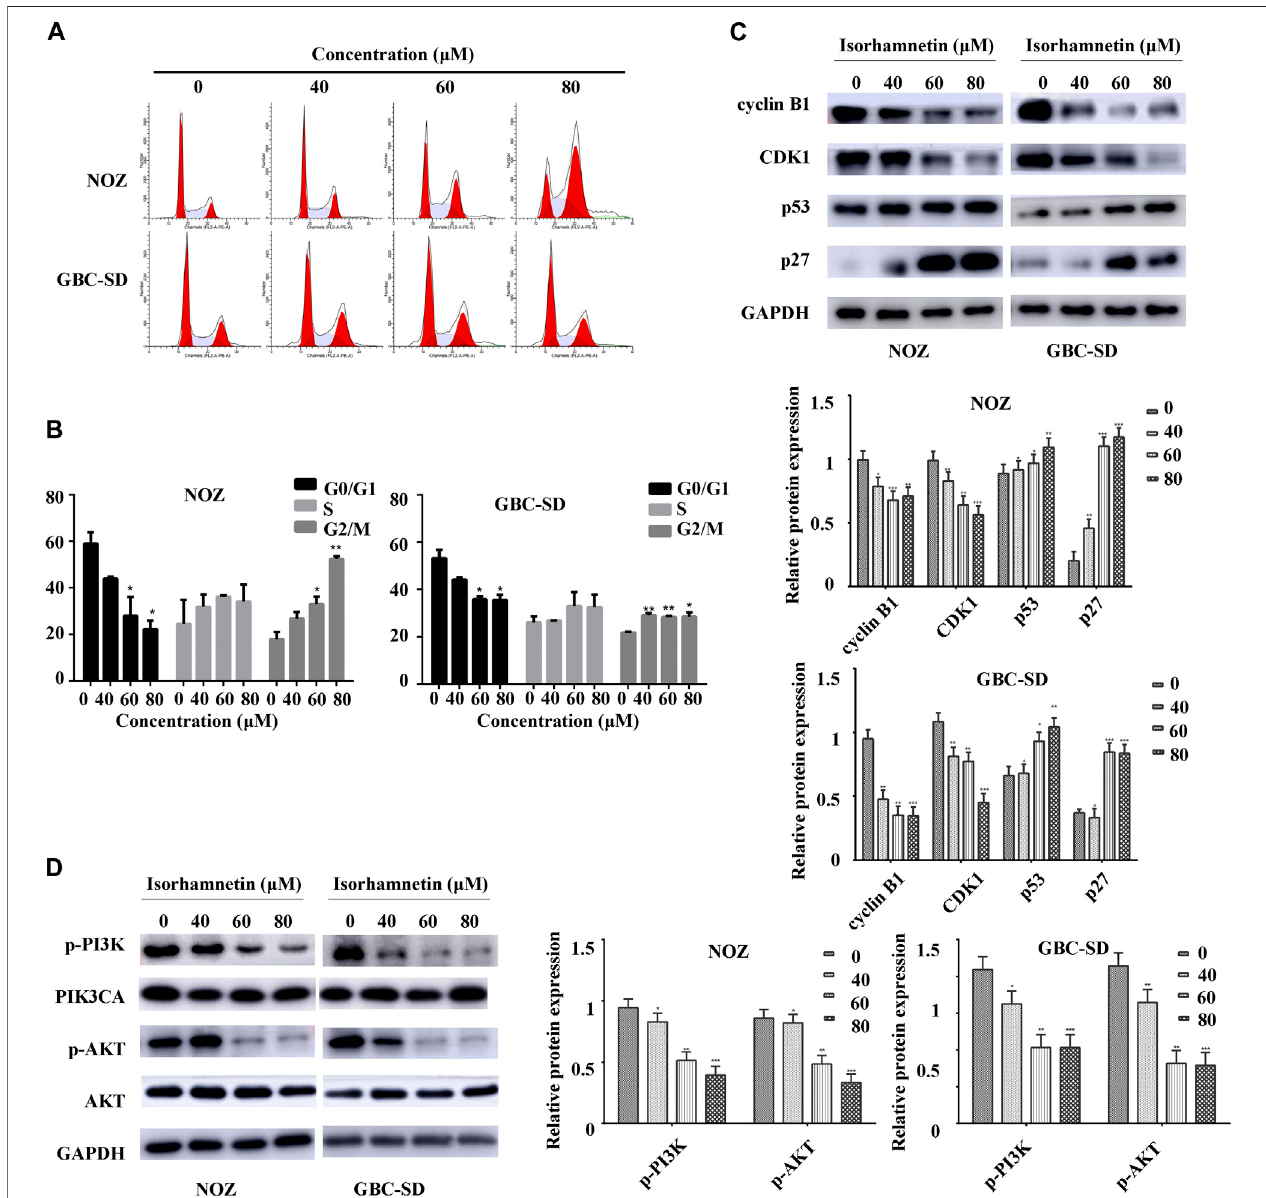
FIGURE4| IsorhamnetintriggerscellcyclearrestintheG2/MphaseandregulatesPI3K/AKTcascade. (A) CellcyclephasesofNOZandGBC-SDcellsexposedto isorhamnetin(0, 40,60,and 80 μ M) for48 hanalyzed using fl owcytometry. (B) Cell cyclephase distributionindicated asthemean ± SD( n (cid:2) 3). (C) Levelsofexpression of cyclin B1, CDK1, p27, and p53 were determined using western blot assessment. (D) The expression levels of p-PI3KP85 α / γ / β -Y467/Y199/Y464, p-AKT1 (T450), PIK3CA, and AKT were detected. * p < 0.05, ** p < 0.01 relative to the control group.